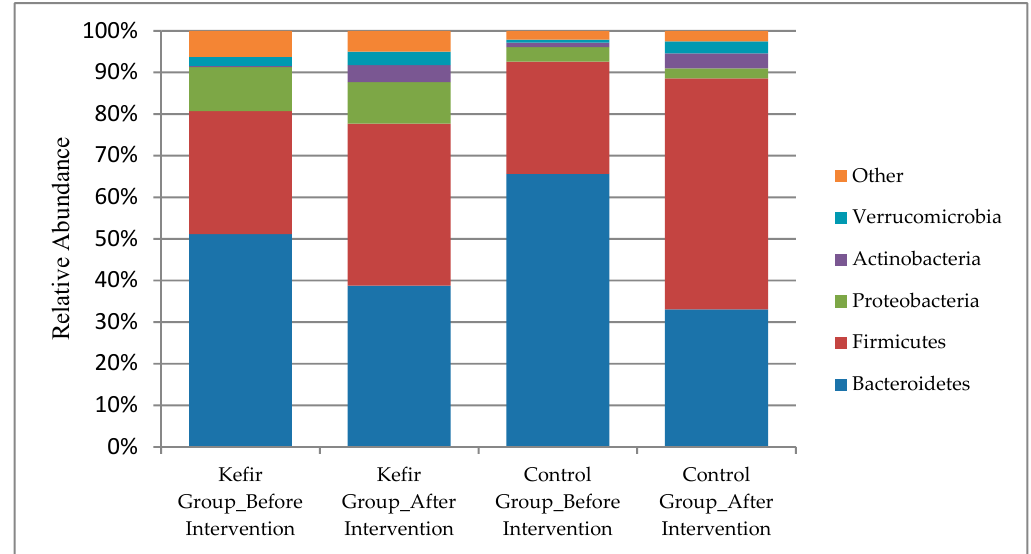
Figure 2. Gut microbiota composition before and after the intervention in each group.